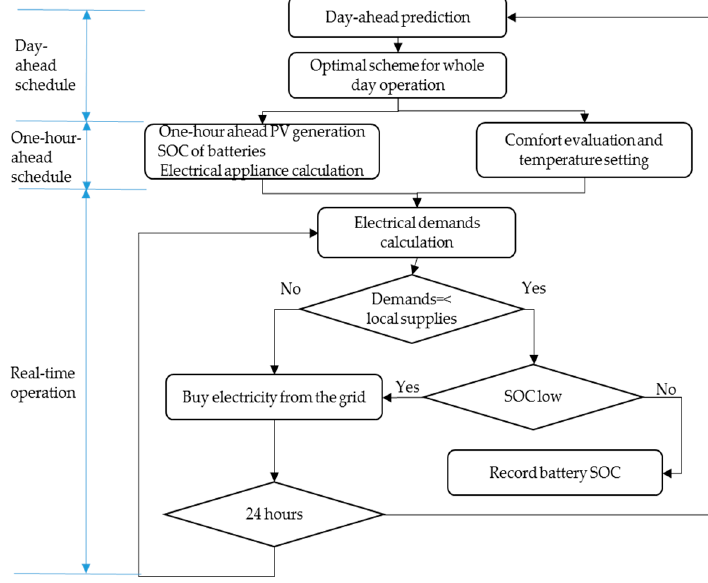
Figure 2. Flow chart of DR-enabled energy management